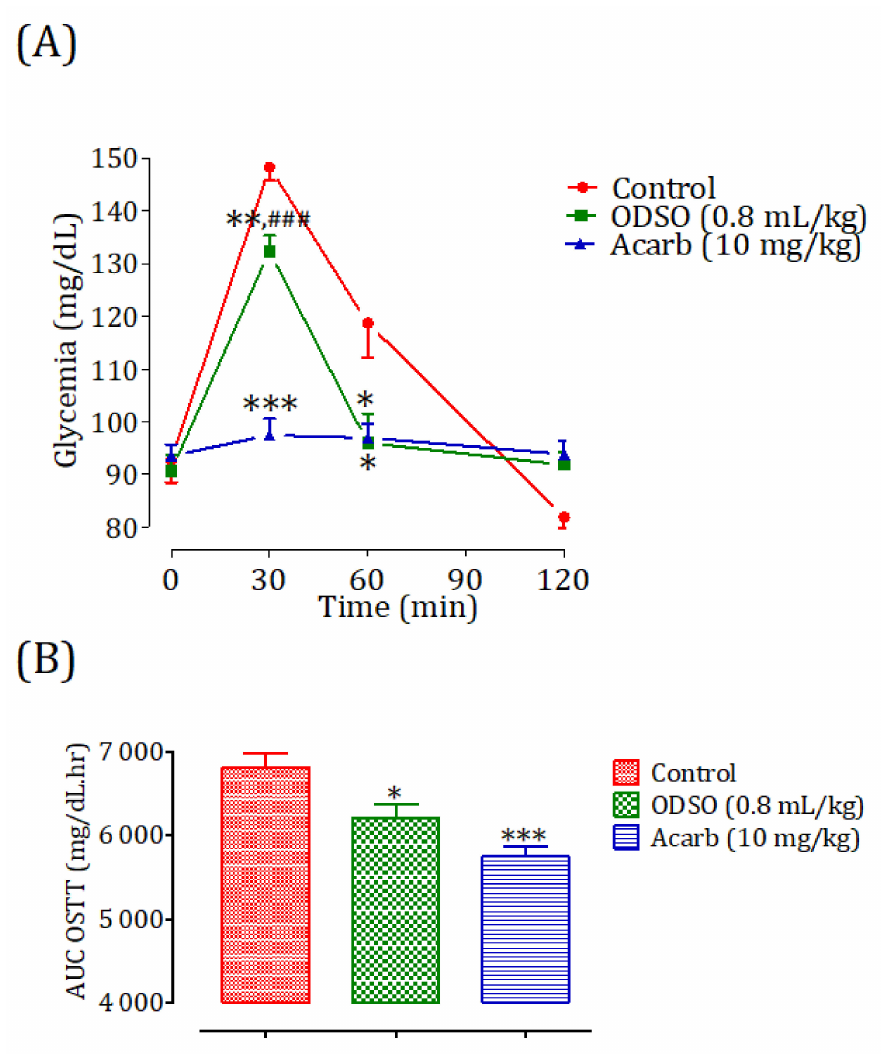
Figure 7. Effect of ODSO and acarbose on the change in the postprandial glycemia in normal rats ( A ), with a representation of the area under the curves ( B ). ODSO: Opuntia dillenii seed oil. The values are the means ± SEM ( n = 6). * p < 0.05, ** p < 0.01, and *** p < 0.001 compared to the control and ### p < 0.00: compared to the acarbose